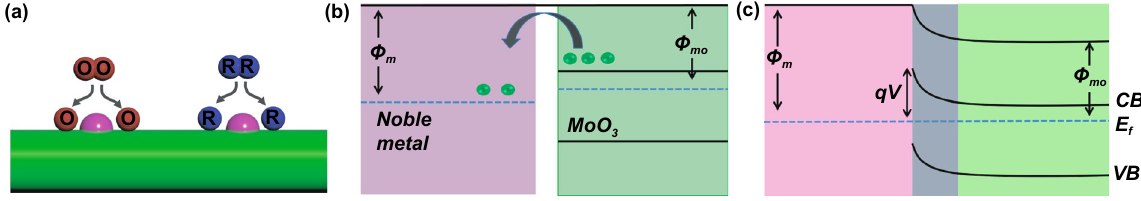
Fig. 4 a Spill-over effect or chemical sensitization induced by noble metal on the surface of MoO 3 . b, c Electron transfer from MoO 3 to noble metal right after making contact along with Fermi alignment that generates Schottky barrier at the interface of noble metal/MoO